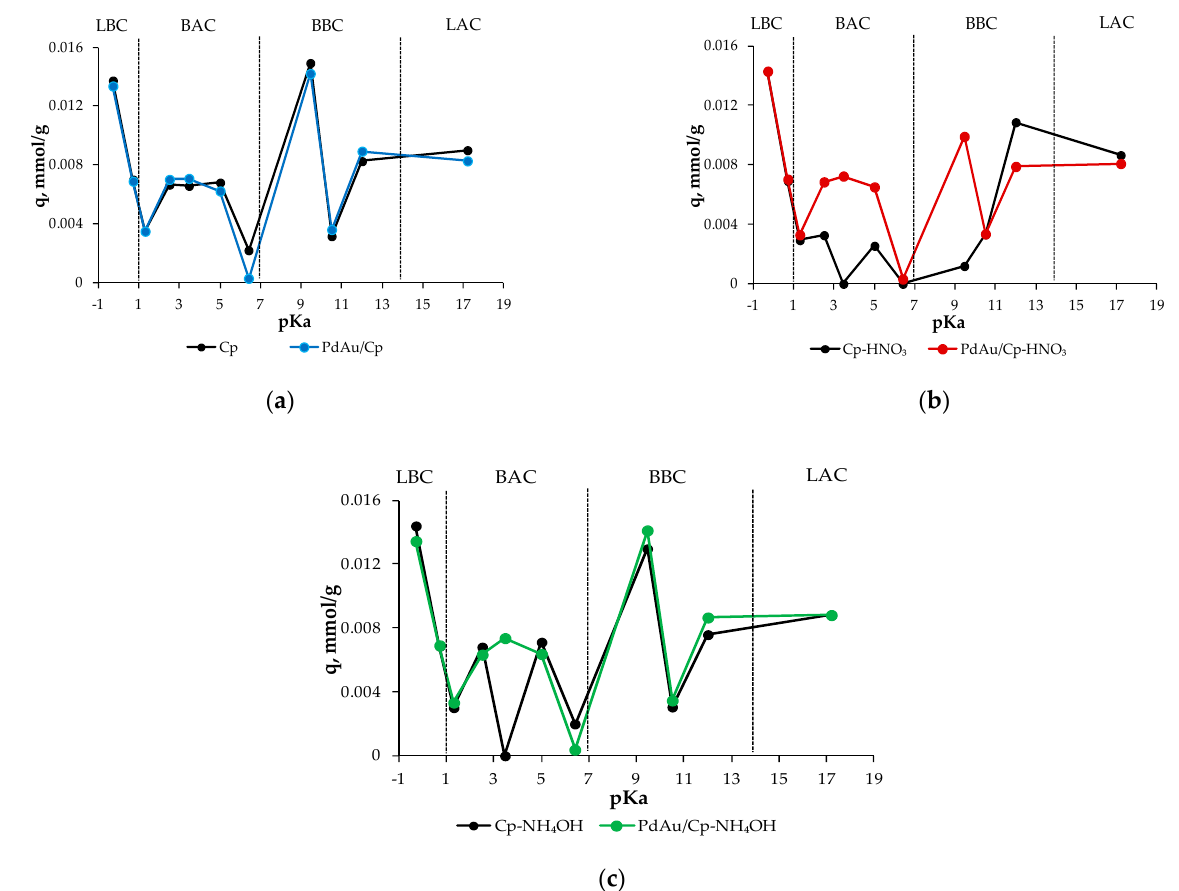
Figure 6. Distribution of acid-base adsorption centers on the surface of PdAu/Cp ( a ), PdAu/Cp-HNO 3 ( b ) and PdAu/Cp-NH 4 OH ( c ) catalysts and their corresponding supports.